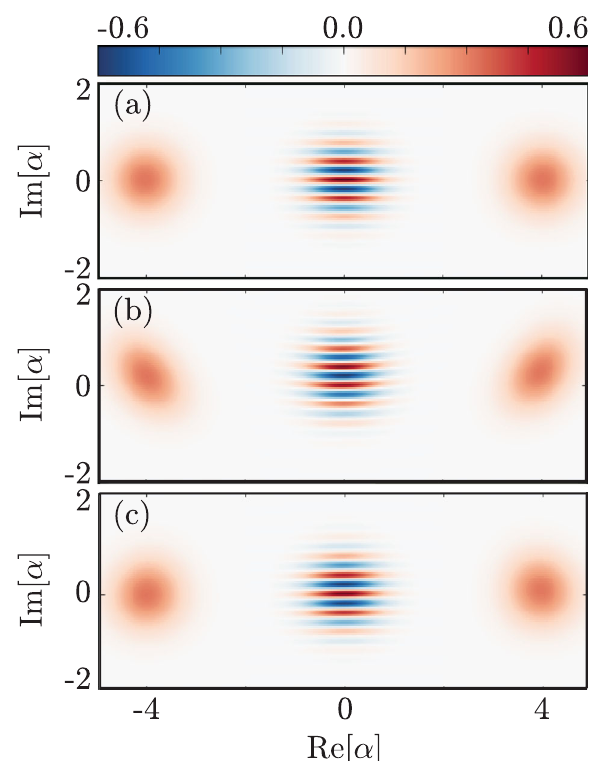
Fig. 4 Wigner function of fi nal state under qcMAP gate with a ideal dispersive Hamiltonian, b full Jaynes – Cummings Hamiltonian and c full Jaynes – Cummings Hamiltonian and two-photon